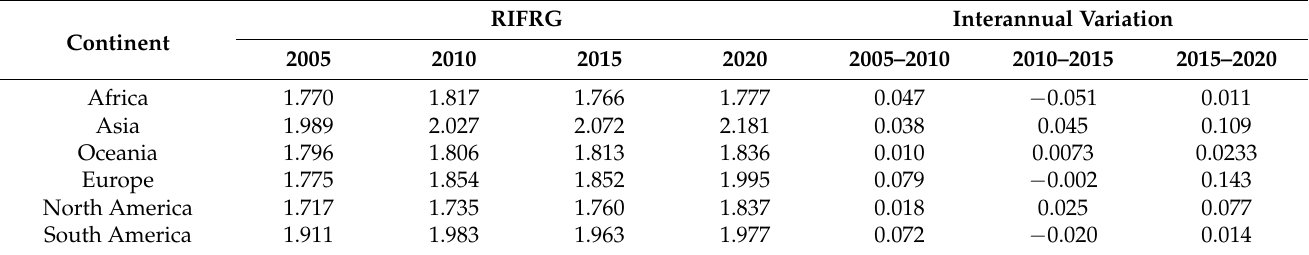
Table 8. Statistics of continental RIFRG values for 2005, 2010, 2015, and